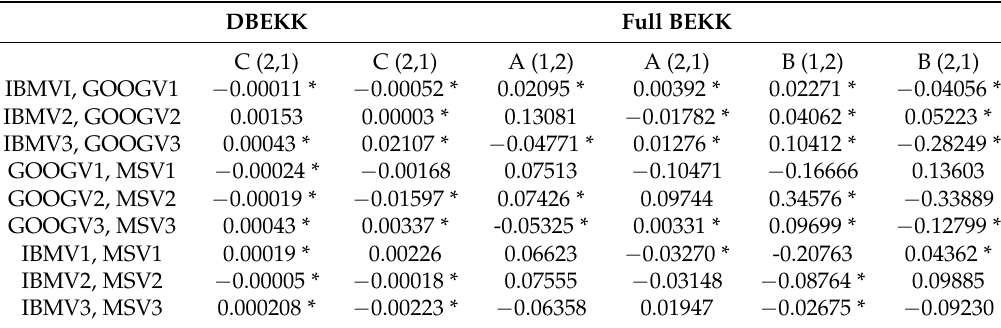
Table 5. Conditional covariance coefficient estimates for DBEKK and Full